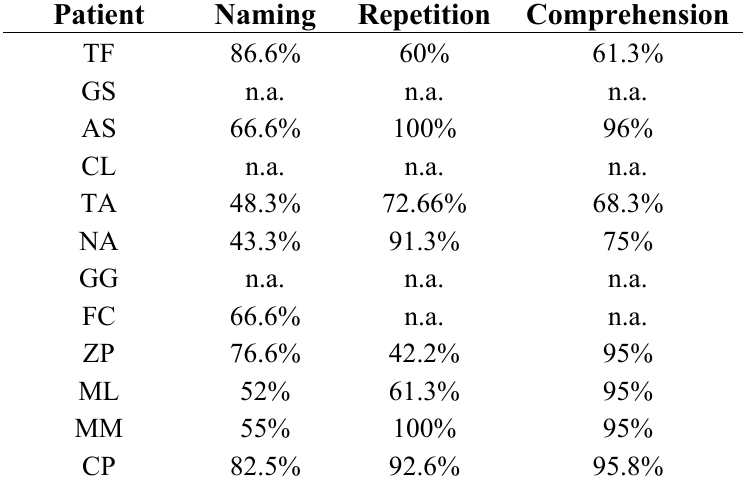
Table 3. Language examination scores of the 12 LBD patients. Since patients were evaluated in different structures and therefore submitted to different standardized batteries, scores are reported in percentage of correct responses; n.a. = not